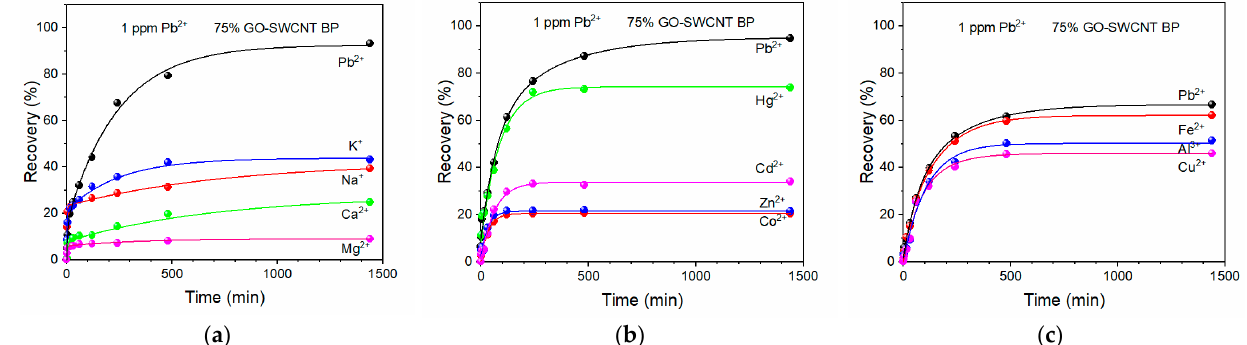
Figure 5. Pb 2+ recovery by 75% GO-SWCNT BPs during the soaking in 800 mL of: ( a ) a mineral water solution with [Pb 2+ ] of 1 ppm, ( b ) a multielement heavy metal solution with Pb 2+ , Co 2+ , Zn 2+ , Cd 2+ , and Hg 2+ , ( c ) a multielement heavy metal solution with Pb 2+ , Fe 3+ , Al 3+ , and Cu 2+ . The concentration of each heavy metal in the multielement solutions was 1 ppm.